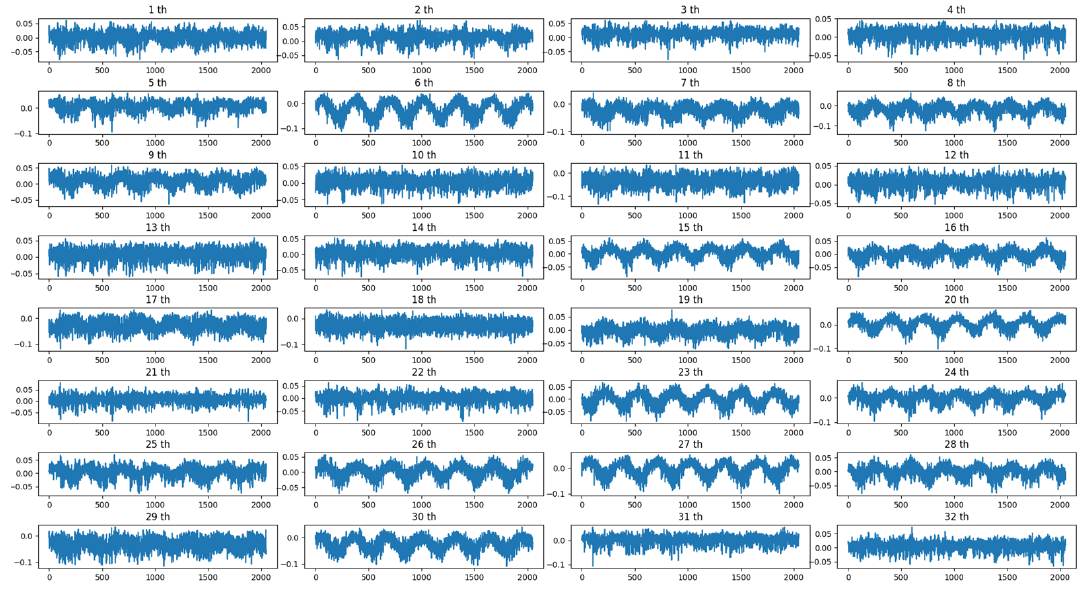
Figure 12. Clustering effect of different convolution layers under T-SNE: ( a ) first layer; ( b ) fifth layer.